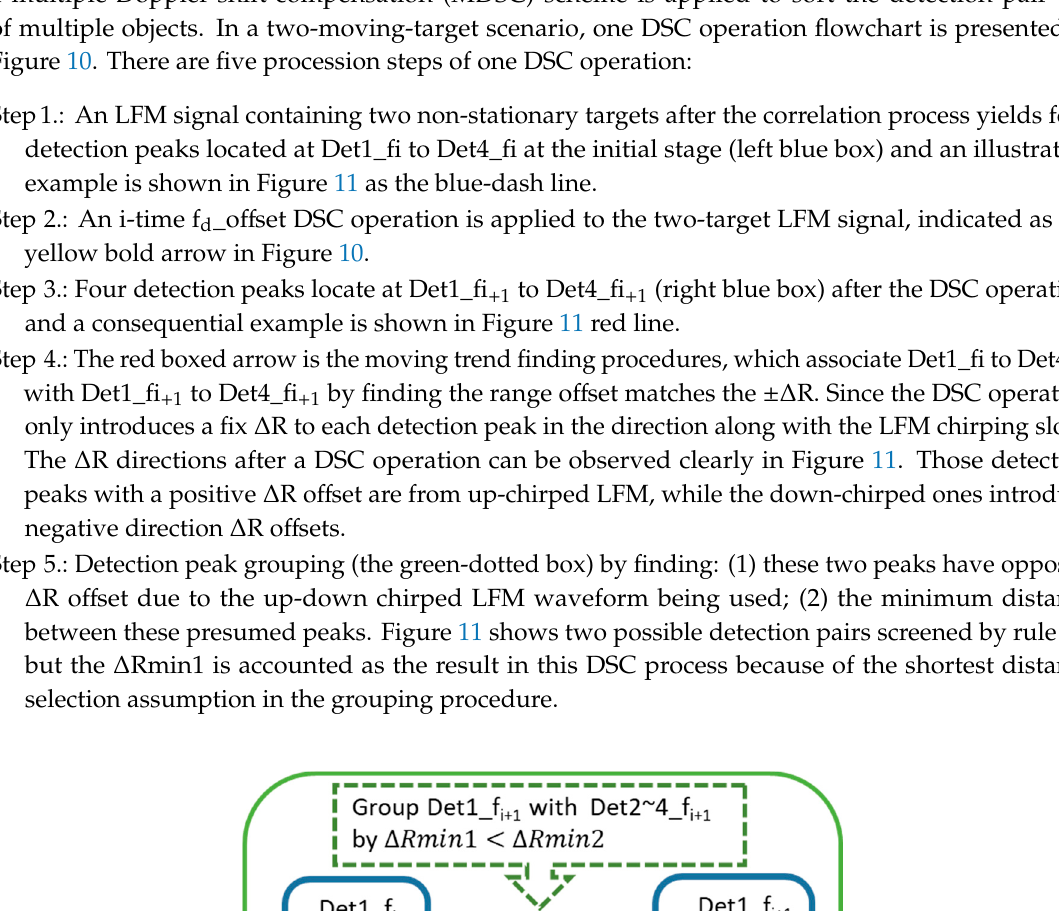
Figure 11. Two moving target MDSC of Figure 5 Case 1 scenario. The signal is traced from one f d _offset Hz DSC (blue-dotted line) to two f d _offset Hz DSC (red line). The overall flowchart of three-MDSC is presented in Figure 12. There are three identical DSC operations with one to three times f d _offset applied respectively to estimate the pairing indexes of two objects, as shown in the green dash-line box scheme. During each DSC operation, the location of DetX_f i+1 can only be found by a specific DetX_f i Δ R, each DetX always has one possible match